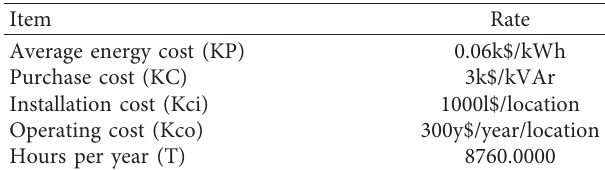
Table 2: Rates for energy, purchase, operation, and maintenance costs.